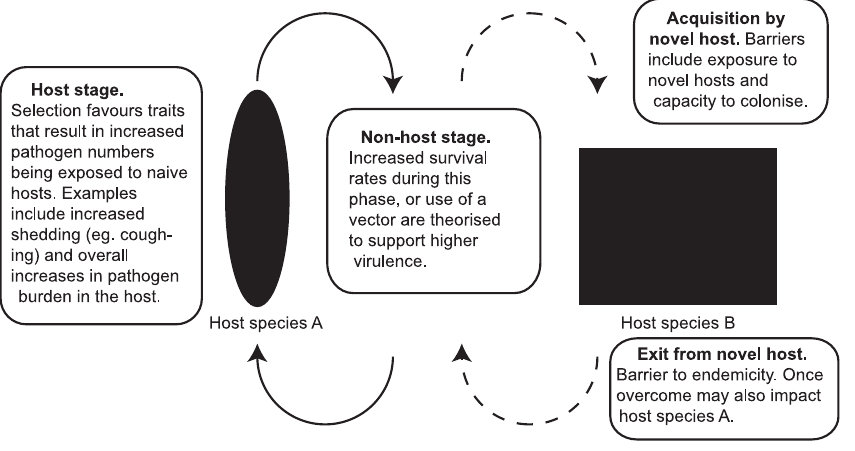
Figure 1. Flow Diagram of a Generic Pathogen Life Cycle Indicating the Selective Pressures That Have Been Suggested or Shown to Be Important in Shaping Pathogen Virulence The filled ellipse represents host species A (the major host), and the filled rectangle represents host species B (the novel